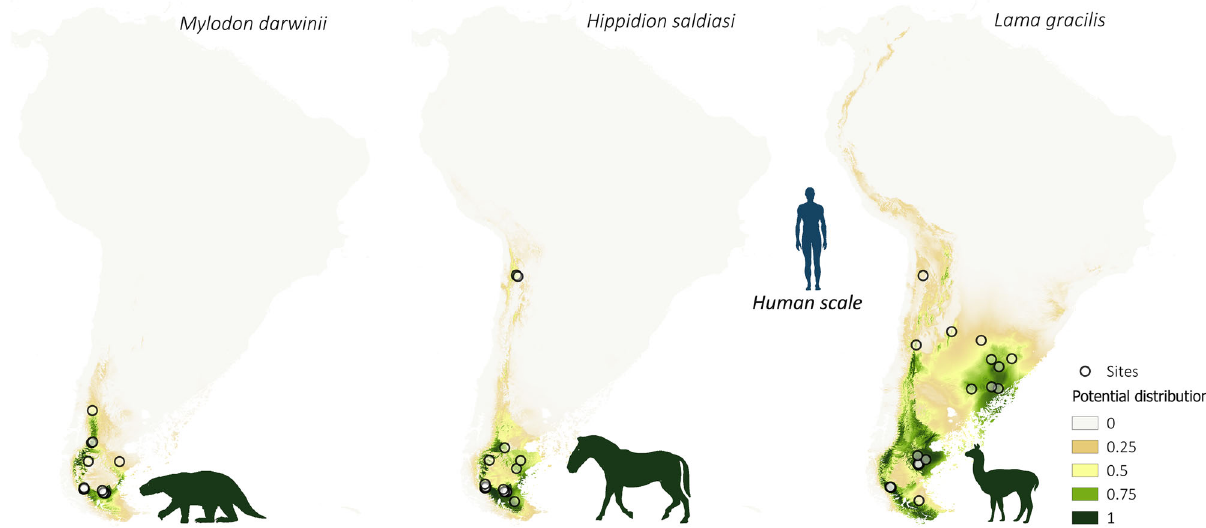
Fig. 3 Spatial distribution of southernmost megafaunal species. Potential distribution maps of the Mylodon darwinii , Hippidion saldiasi, and Lama gracilis during the late Pleistocene – early Holocene (18 k – 9 k cal BP). Values of potential distribution vary from 0 (light beige) to 1 (dark green). Empty dots represent species occurrence sites. The taxonomy of Lama gracilis is under discussion. It has been mainly considered a vicariant of Vicugna vicugna in the low plains, but some morphological and molecular studies suggest that L. gracilis and V. vicugna may be the same species 65 – 67